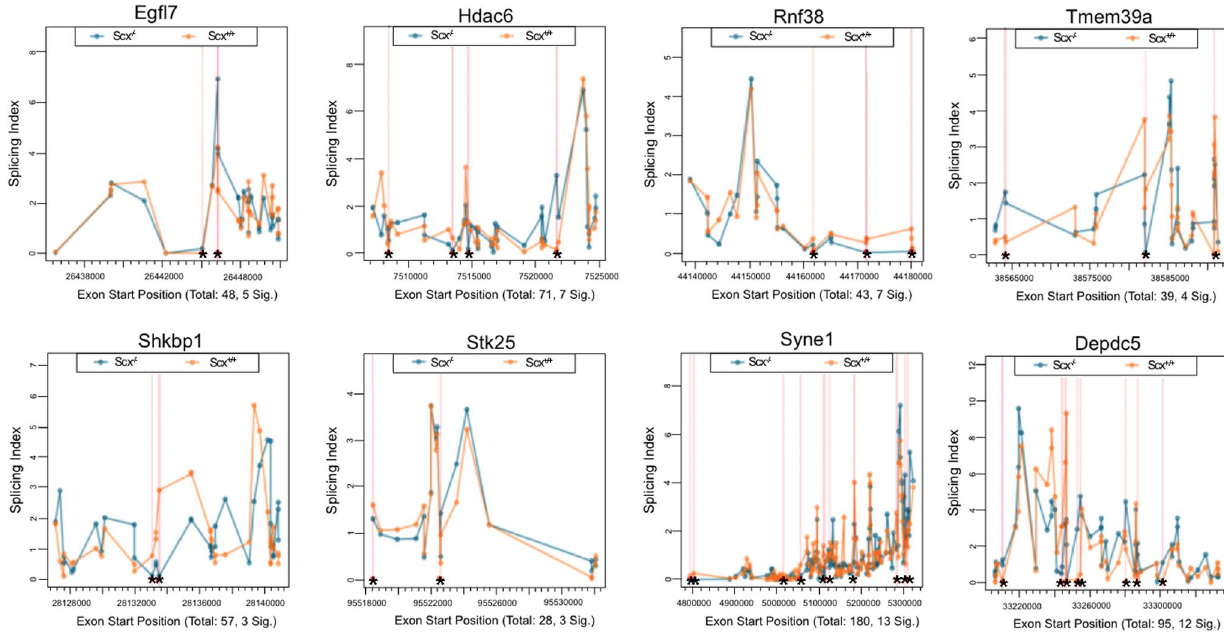
Figure 4. Exon-level splicing indices of mRNAs affected by alternative splicing events in Scx -/- samples at E15.5. Splicing indices of the top 8 mRNAs affected by changes in exon abundance (at least 10 exons) in the absence of Scx. * indicate significant differences in exon abundance (p , 0.05).